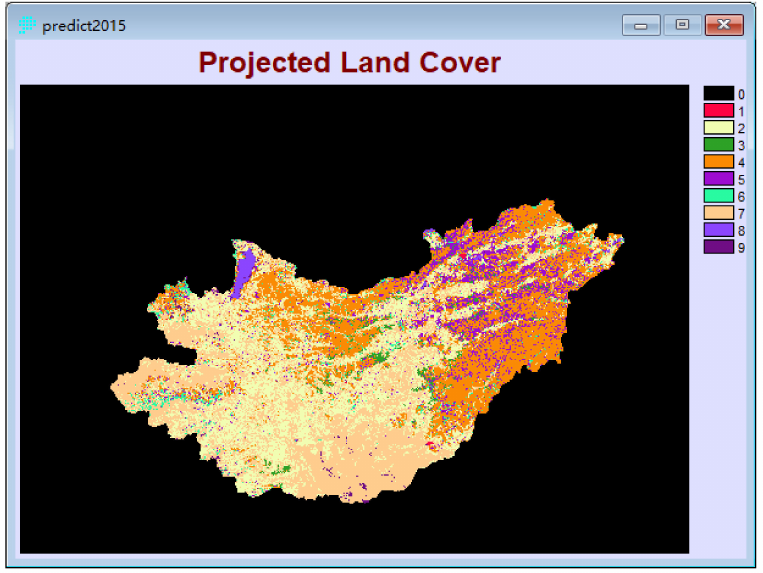
Figure 11. Land use Prediction in 2015.